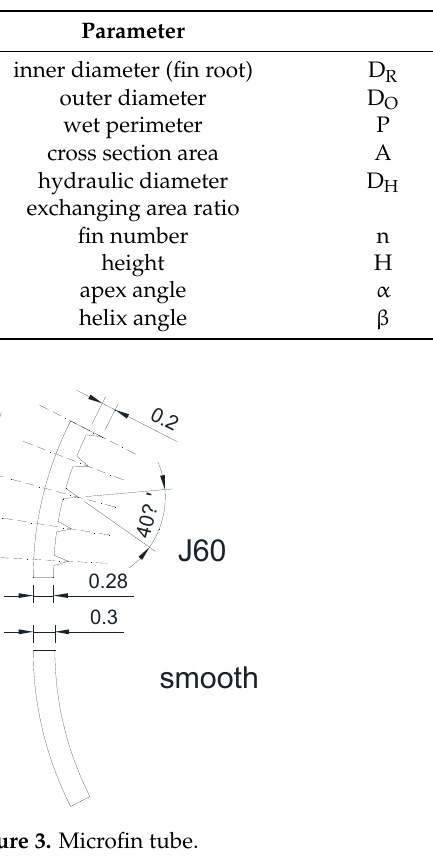
Table 1. Microfin tube geometrical features.